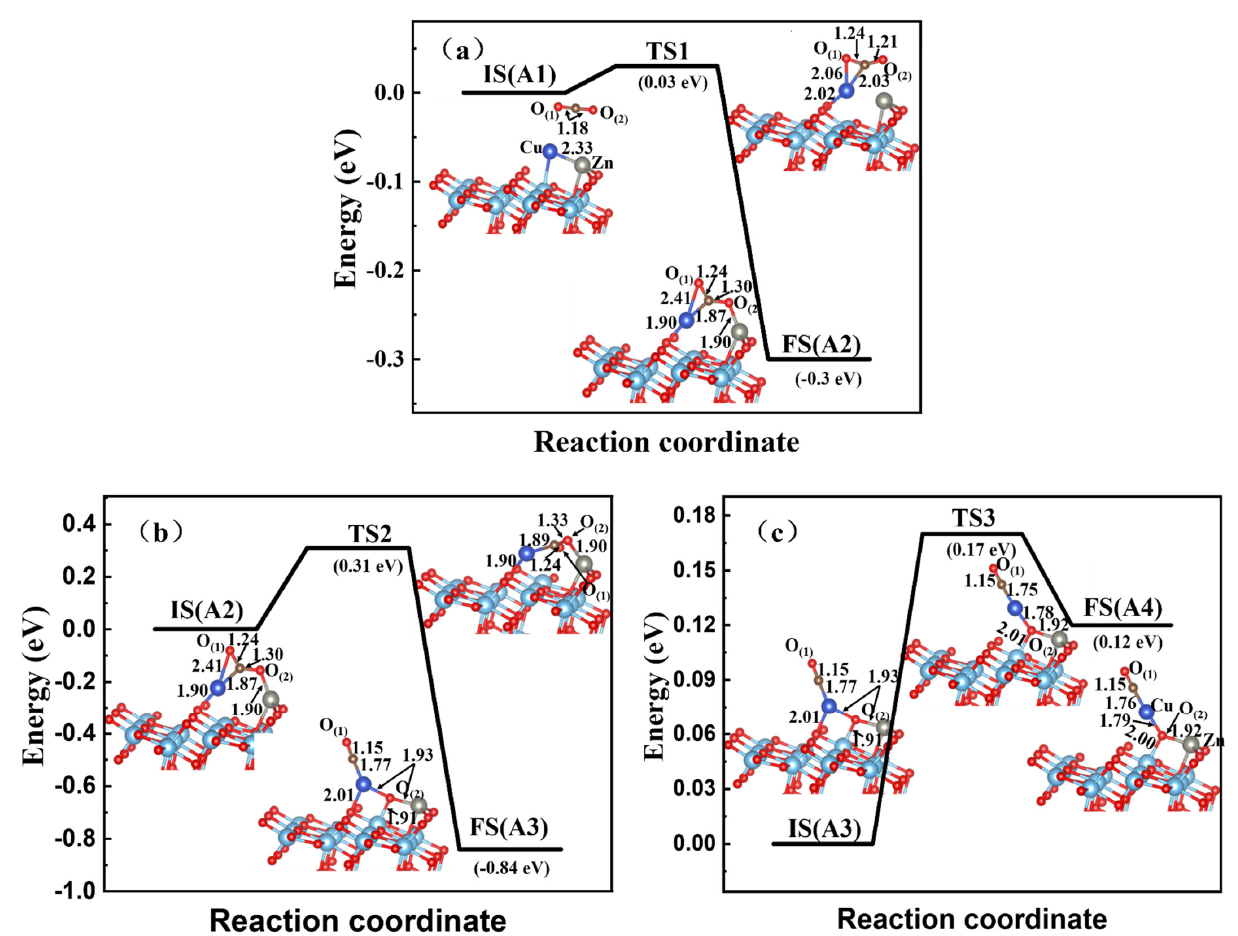
Figure 6. CO 2 reduction on the Zn-Cu-embedded A-TiO 2 (101) surface. For the A-TiO 2 system, the bond unit was Å. The Cu atom in dark blue, and Zn atom in light gray. ( a ) is the adsorption process, ( b ) and ( c ) are the two steps of reduction process.